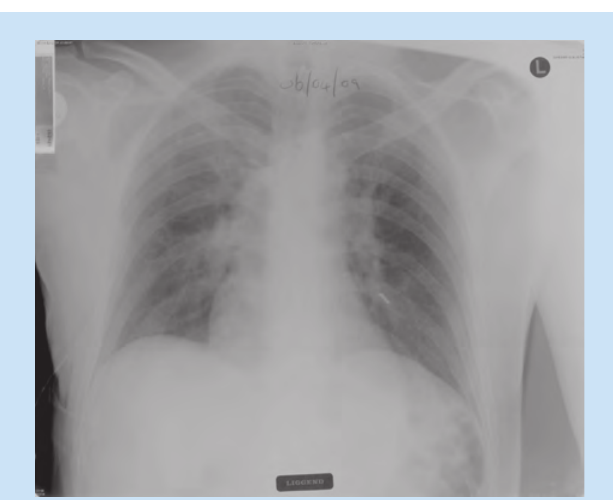
Fig. 3. The same metal object that was visible previously in the pelvis can now be seen in the left lower lung region.